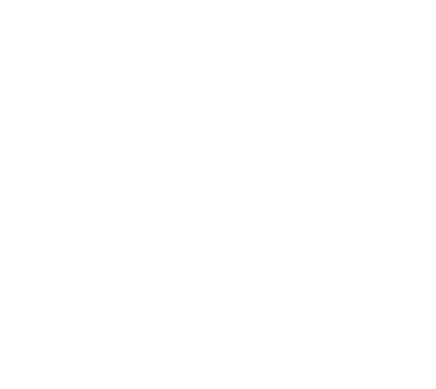
Table 4. Proteins for the 10 most dysregulated